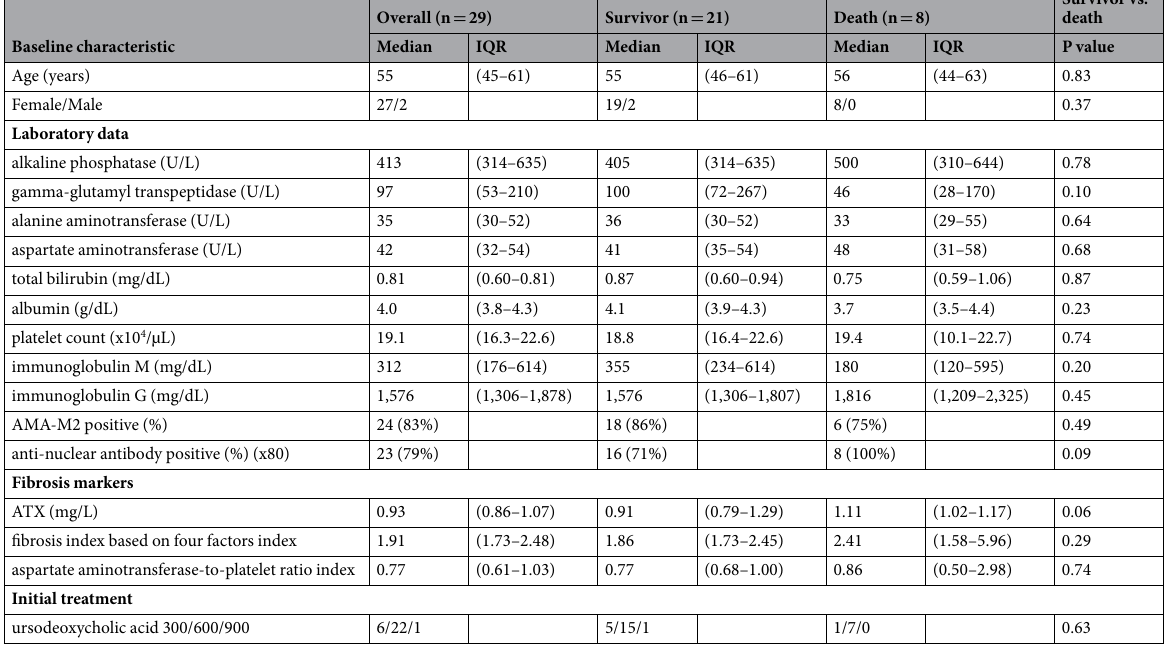
Table 3. Clinical characteristics of 29 patients with primary biliary cholangitis in a longitudinal study of 18 years. Data are expressed as the number (%) or median (first-third quartiles). Abbreviations: IQR,